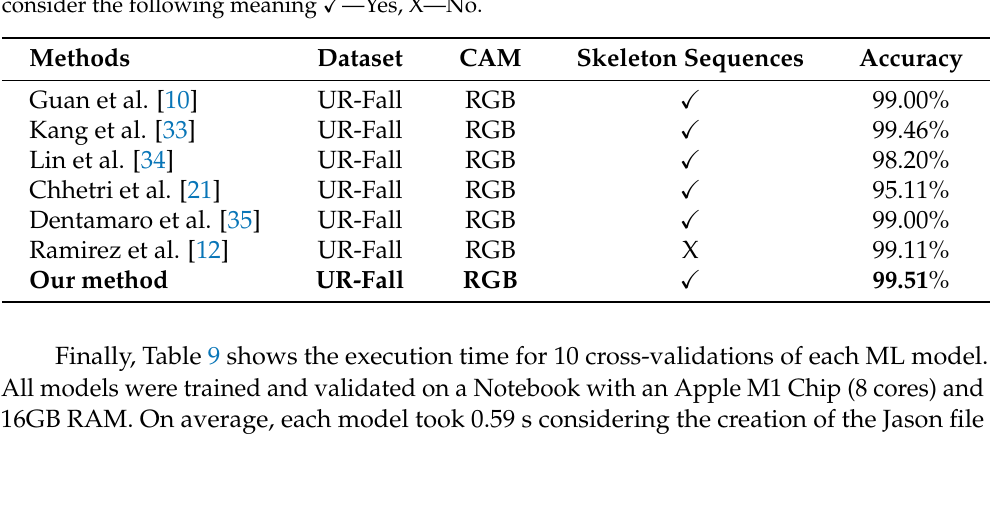
Table 8. Comparison with other methods using skeletons for fall detection with UR-Fall. Please consider the following meaning (cid:88) —Yes,